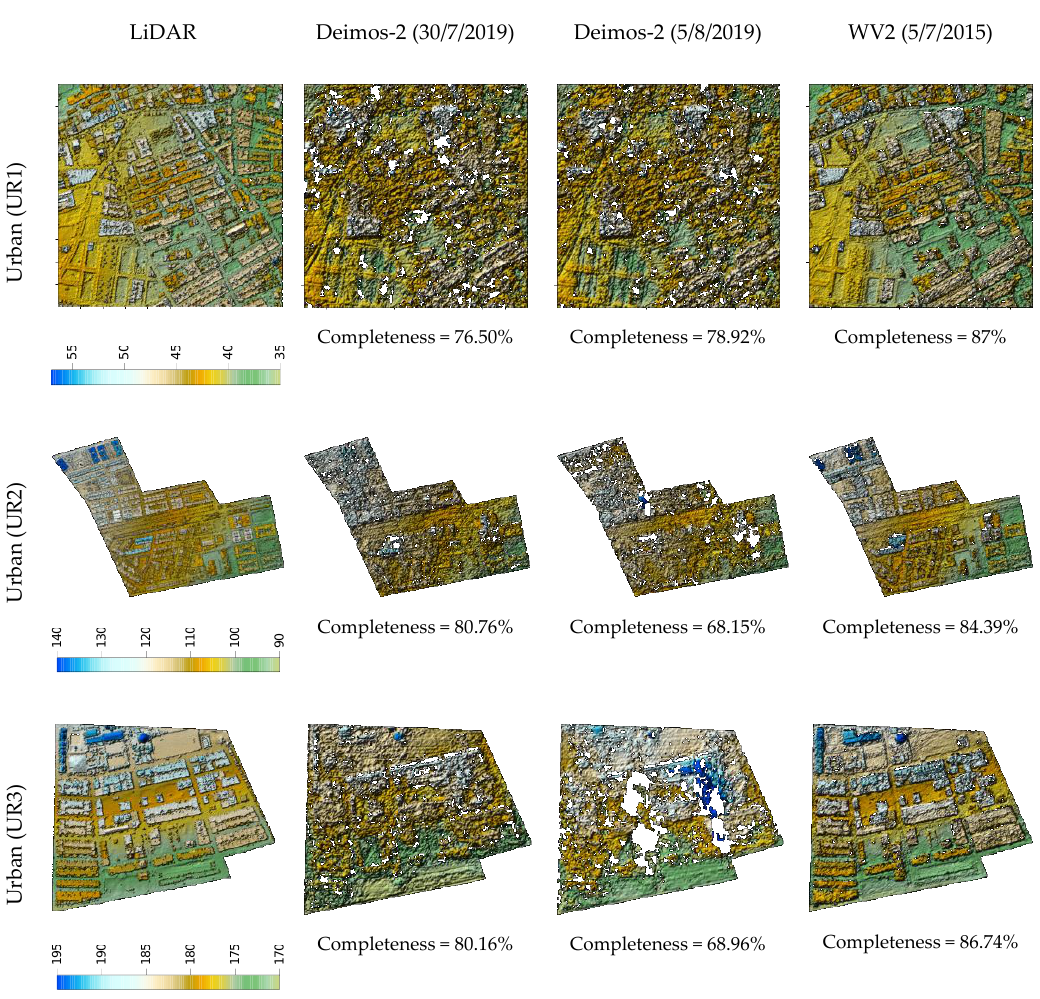
Figure 4. DSMs and completeness values corresponding to the three subareas of urban land cover (UR1, UR2 and UR3) generated from the first and second Deimos-2 stereo pairs (second and third column) and the WV2 stereo pair (fourth column). The reference LiDAR is depicted in the first column.